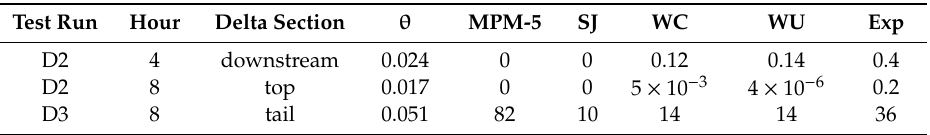
Table 7. Calculated and measured transport rates in (kg / hm) of sections which are located at the downstream end of the experimental